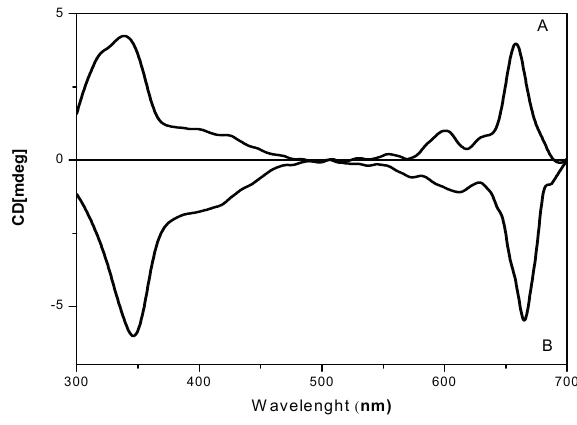
Figure 3. Circular dichroism (CD) spectra of optically active phthalocyanines 11 ( curve B ) and 12 ( curve A